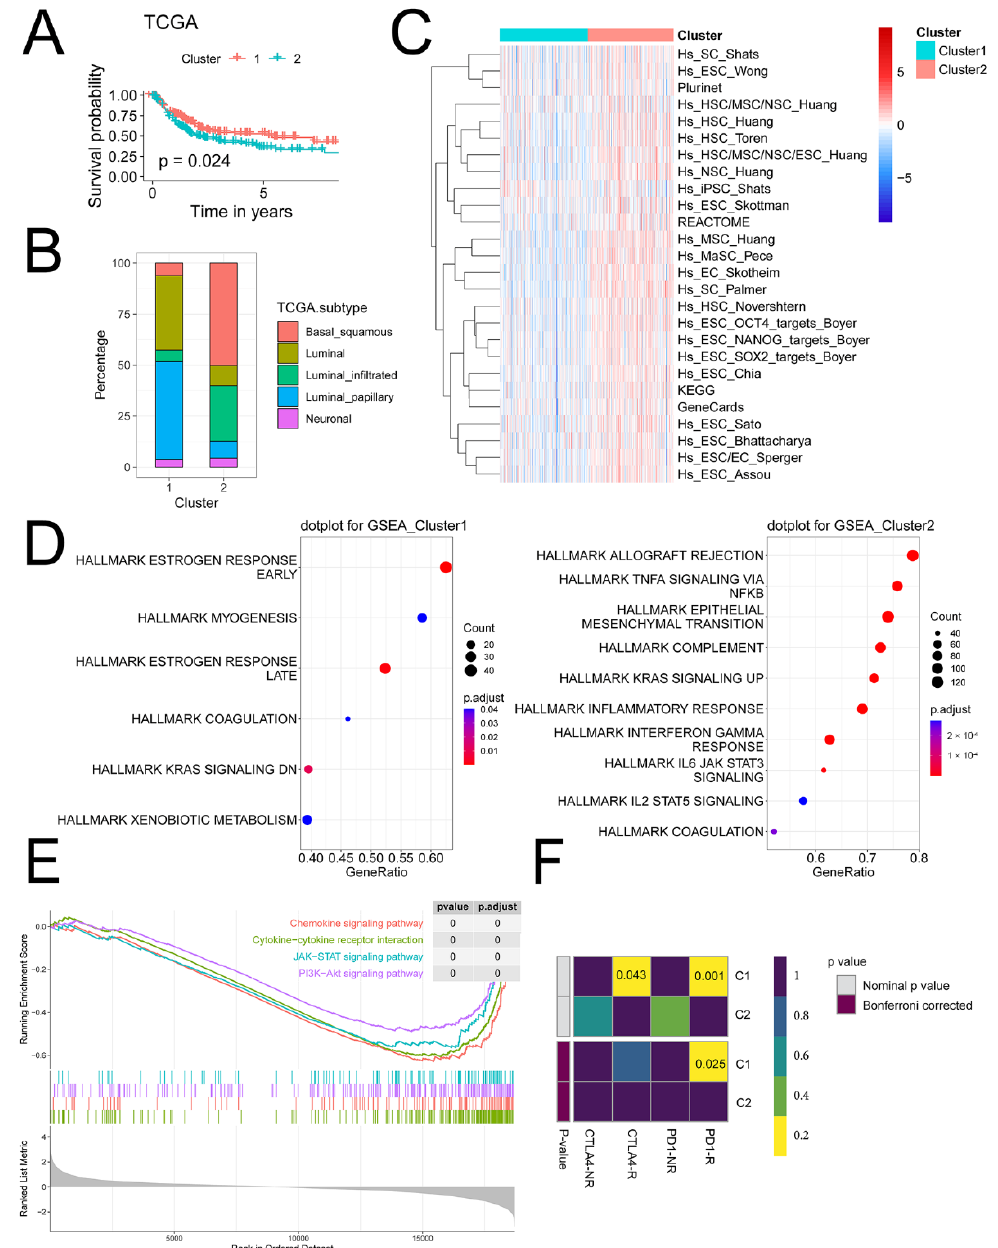
Figure 3. iCAF-related subtypes had distinct dysregulated pathways: ( A ) Cluster 2 was related to a worse prognosis in TCGA-BLCA. ( B ) Consensus TCGA molecular subtypes between two clusters. ( C ) The enrichment activity of 26 stemness-related signatures between two clusters. ( D ) Upregulated cancer hallmarks of Cluster 1 (left) and Cluster 2 (right). ( E ) Upregulated pathways of Cluster 2. ( F ) Immunotherapy response prediction.